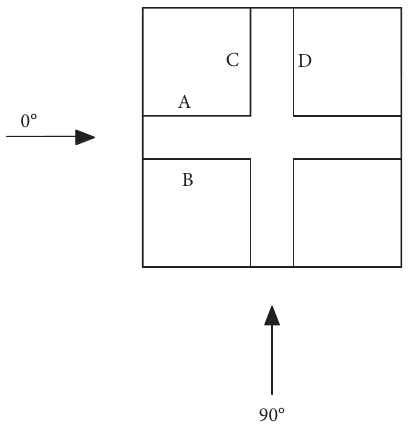
Figure 13: Schematic diagram of the inner wall of the